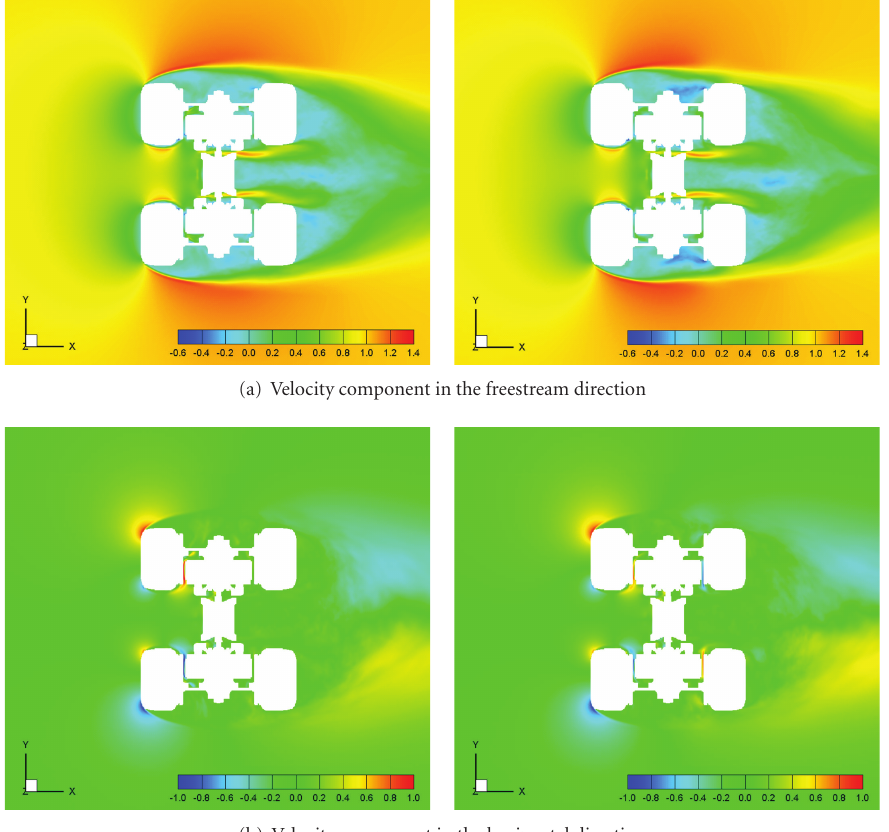
Figure 20: Computed mean velocity component at cross section z = − 2 . 21 (left: NO TEAR, right: NO